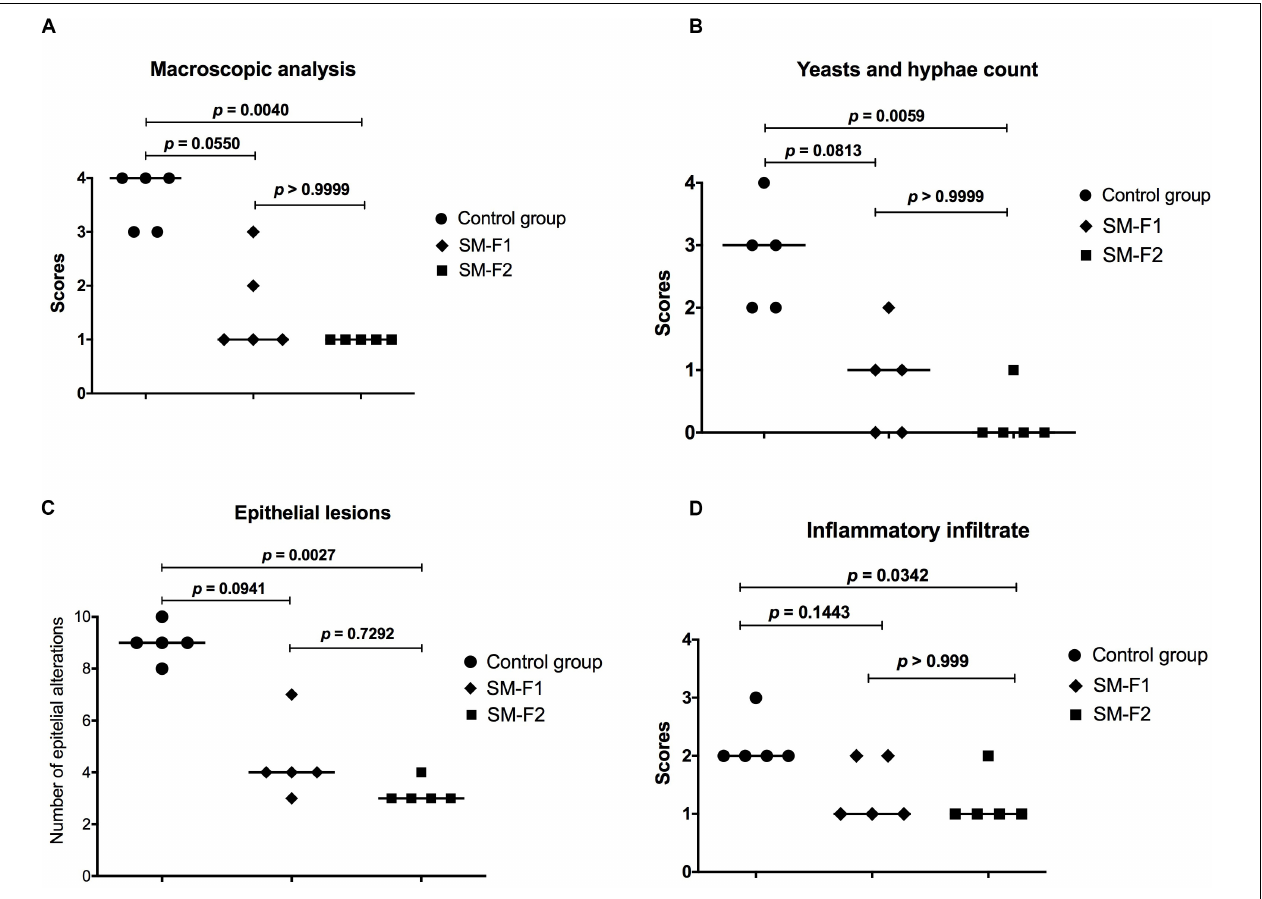
FIGURE 9 | Quantitative analysis of candidiasis lesions formed on the dorsum tongue of mice infected with C. albicans. (A) Scores and medians obtained in the quantification of macroscopic lesions. (B) Scores and medians obtained in yeasts/hyphae counts in the histological cuts stained by PAS. (C) Medians of epithelial lesions determined in the histological cuts stained by H&E. (D) Scores and medians of infiltrate inflammatory intensity in the histological cuts stained by H&E. Kruskal-Wallis and Dunn’s